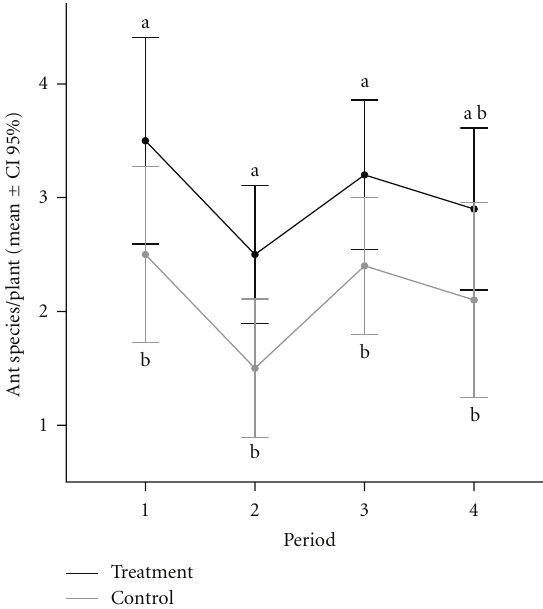
Figure 5: Discriminant analysis comparing the experimental groups (for each period of experiment) using ant species com- position and relative occurrence. With 75.9% of the variance explained by the first and 8.6% by the second function, periods were discriminated in cases with trophobioses and without trophobioses by the high occurrence of the trophobiont ant species Camponotus rufipes and C. crassus in the first group (Wilk’s λ = 0 . 206; P < 0 . 01; C. crassus : F (7;72) = 5.46; P < 0 . 01; C. rufipes : F (7;72) = 3.31; P < 0 . 01; other species did not contribute significantly for the